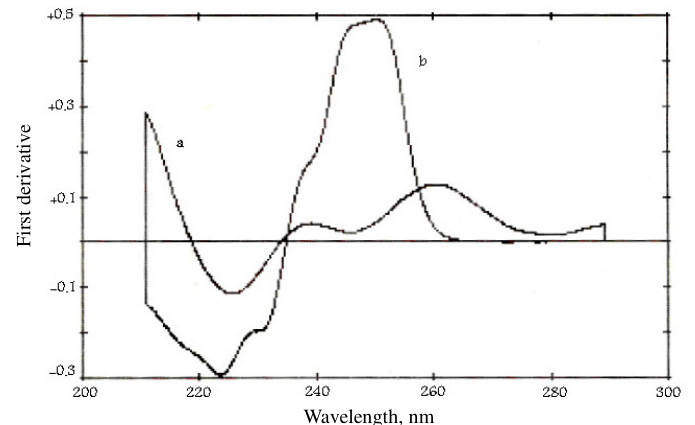
Figure 1. Zero order spectra of (a) ezetimibe (10 µ g/mL) and (b) simvastatin ( 20 µ g/mL)